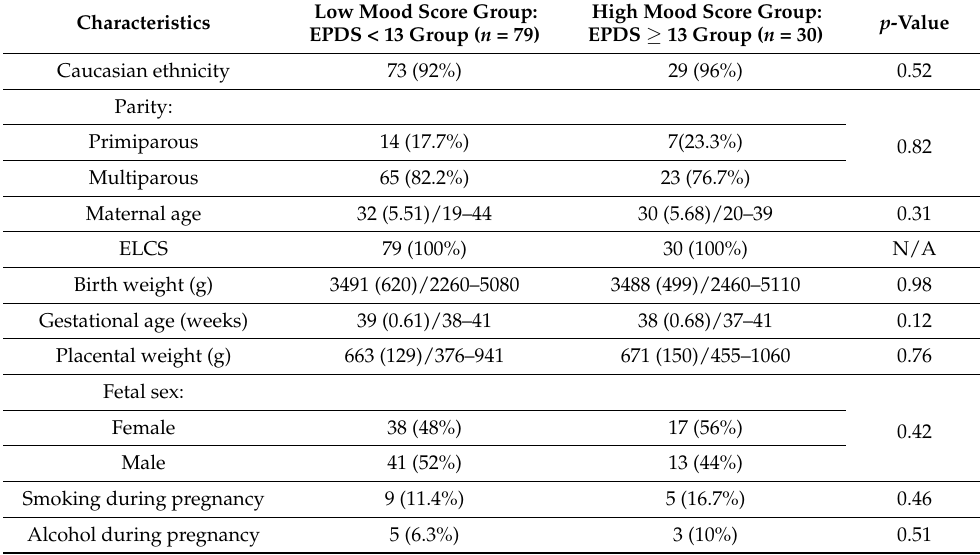
Table 2. Key characteristics of the study participants. Mean (SD)/range or number (%) is shown; p -values were assessed using independent samples t -test or χ 2 test. Due to missing values some numbers do not add up to 100%.